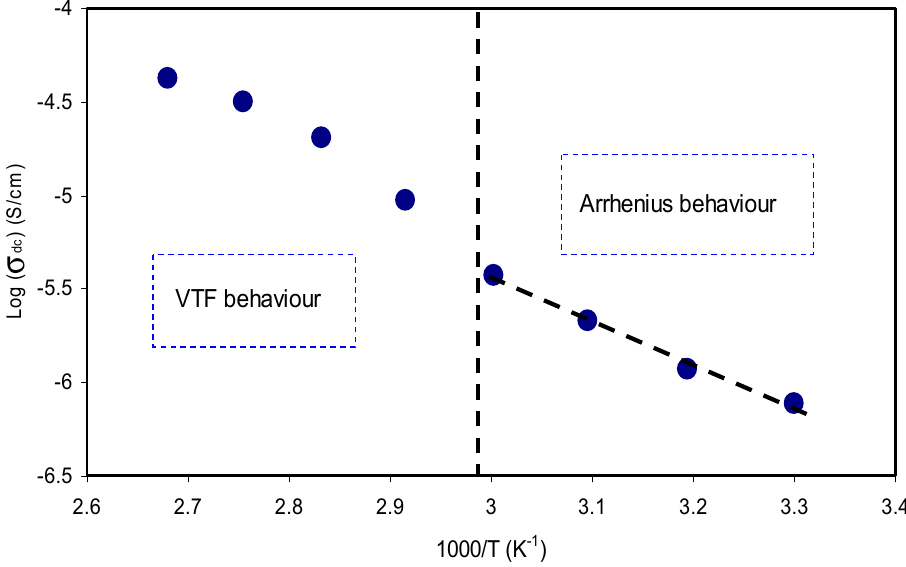
Figure 4. Direct current (DC) ionic conductivity versus 1000/T for CS: POZ: MgTf solid polymer blend electrolyte film.